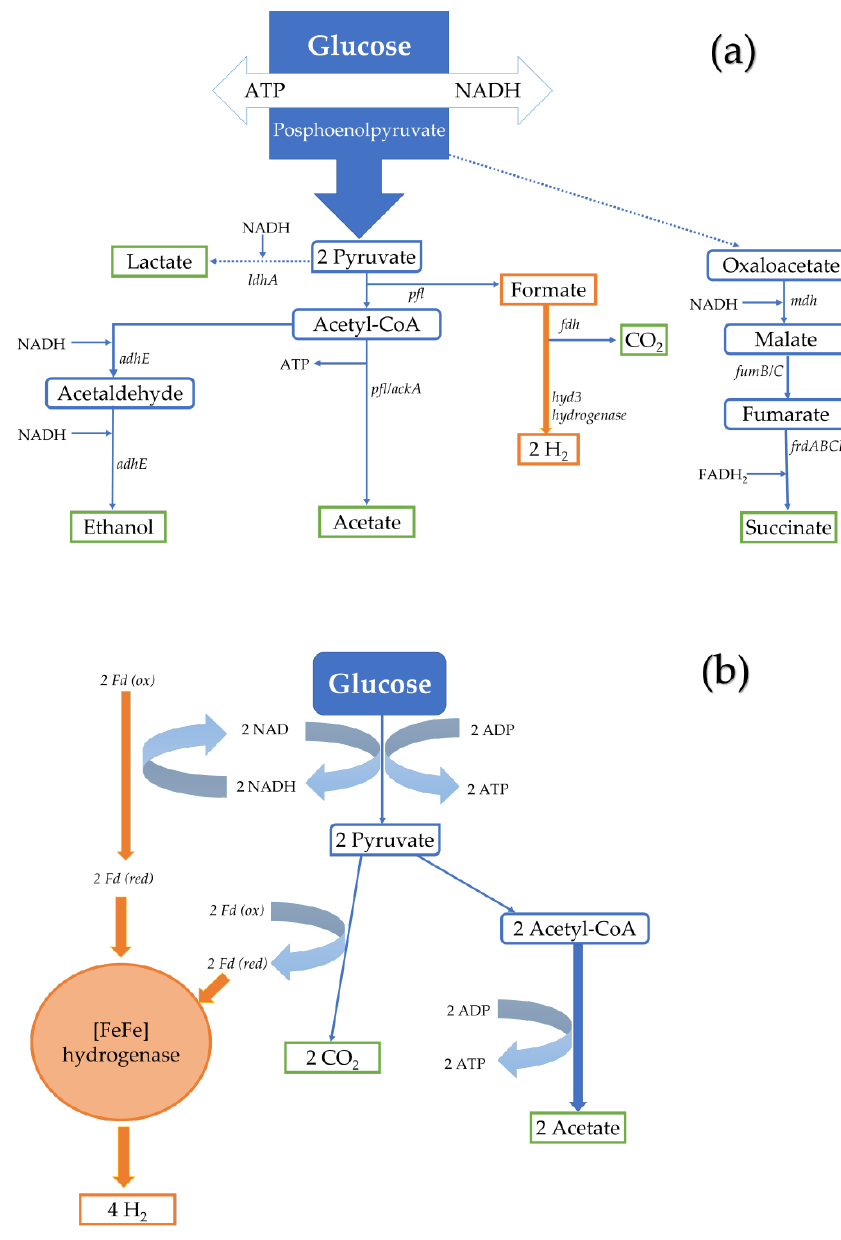
Figure 4. Metabolic pathways of Enterobacter spp. ( a ) and Clostridium spp. ( b ) in dark fermentation. ATP: adenosine triphosphate; NAD(H): nicotinamide adenine dinucleotide; ldhA : lactate dehydroge- nase; pfl : pyruvate formate lyase; fdh : formate dehydrogenase; mdh : malate dehydrogenase; adhE : aldehyde – alcohol dehydrogenase; ackA : acetate kinase; fum : fumarate; frd : fumarate reductase; FADH 2 : flavin adenine dinucleotide; Fd : ferredoxin; ADP: adenosine diphosphate. Dark fermentation can be carried out in both thermophilic and mesophilic conditions. Although the H 2 yield is higher in thermophilic conditions than in mesophilic conditions, the volumetric productivity is reversed